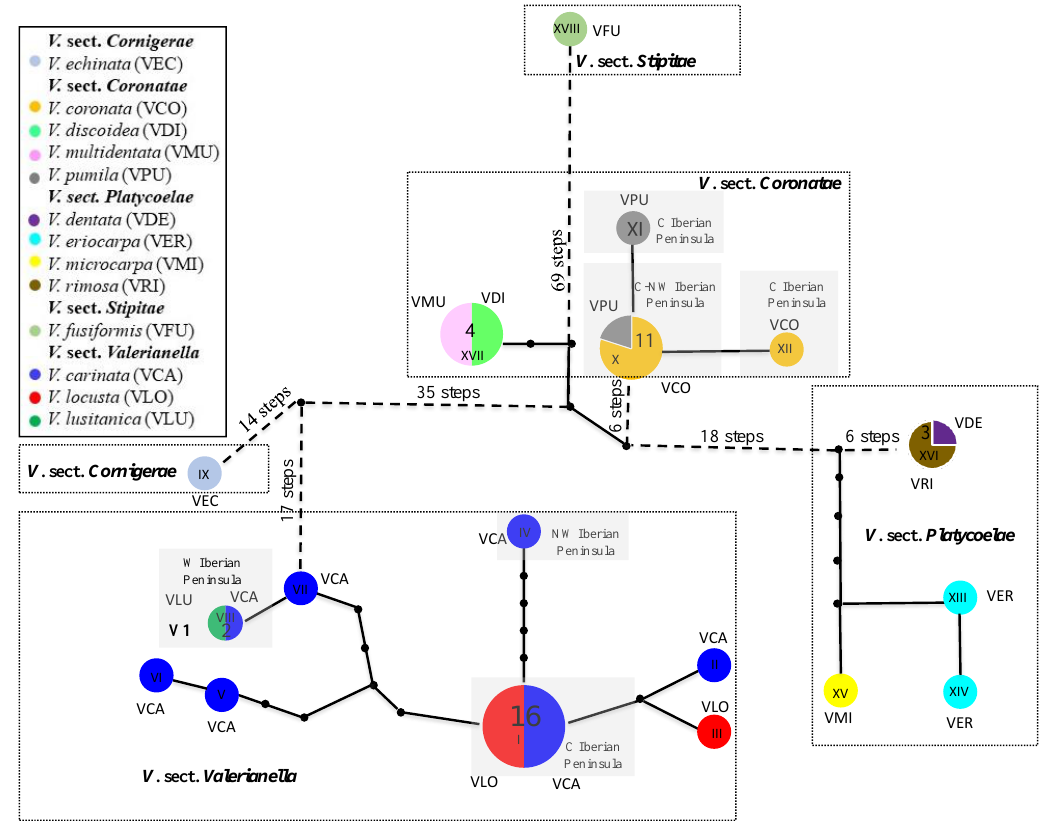
Figure 4. Valerianella trn L-F + trn T-L plastid haplotype parsimony network. Mutation steps are represented by dots (numbers of mutation steps are indicated within parentheses). Color codes of Valerianella species are indicated in the